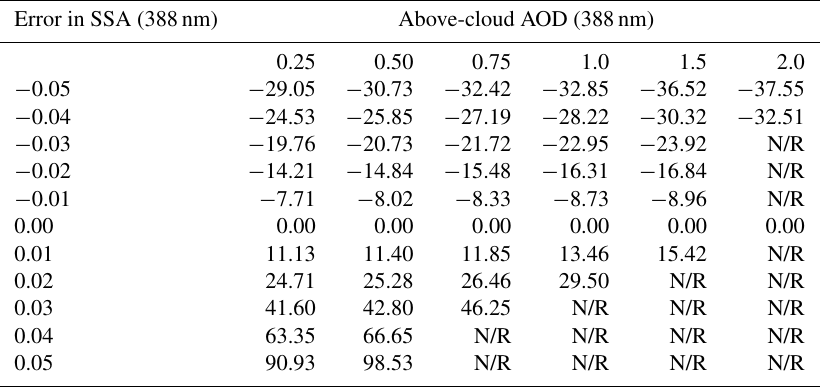
Table 3. Theoretical error (%) in ACAOD (388nm) due to the uncertainty in the assumption of SSA at 388nm. The reference value of SSA (388nm) assumed in the calculation was 0.89; the error in SSA (leftmost column) represents perturbation from the reference value. The cloud optical depth underneath the aerosol layer was assumed to be 10.